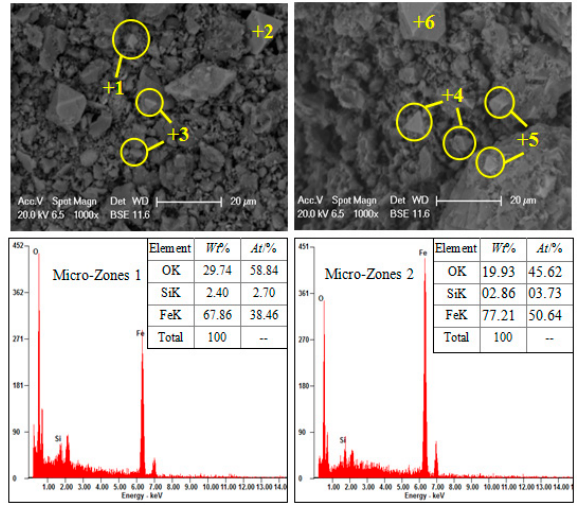
Figure 4. Scanning Electronic Microscopy (SEM) and Electron Probe Microanalysis (EPMA) analysis on tailings II.